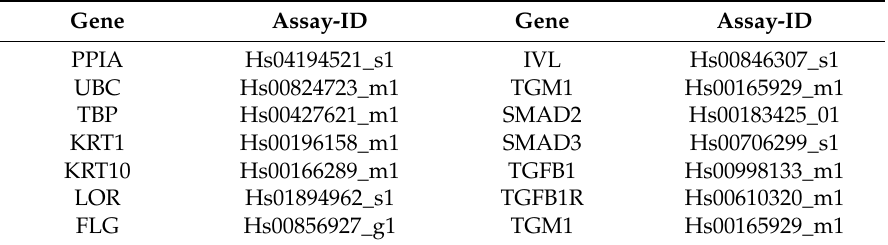
Table 2. TaqMan gene expression assays used for gene expression studies of NHEK by qPCR. Gene Assay-ID Gene